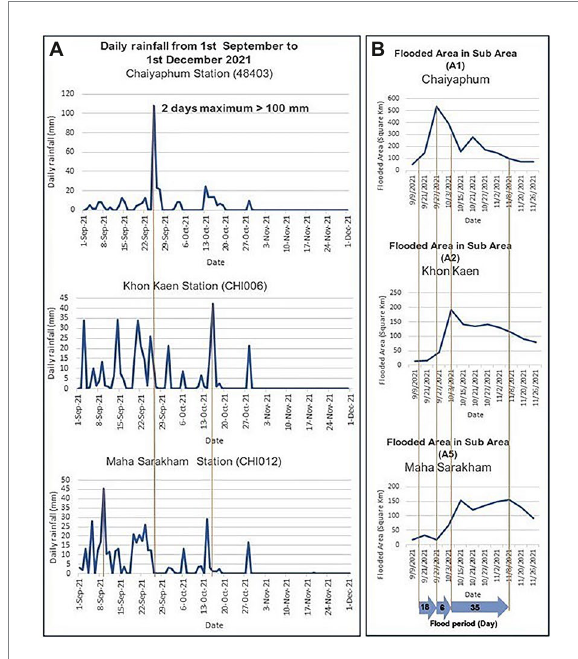
FIGURE 2 (A) Records of daily rainfall on September 1 to December 1, 2021, from the Chaiyaphum, Khon Kaen, and Maha Sarakham weather stations. Only one dominant peak was recorded at 108 mm (top graph) during September 23–25, 2021 at Chaiyaphum, the upstream part of the catchment. The other two stations, situated downstream from Chaiyaphum, showed several peaks in the range of 25–40 mm/day (Khon Kaen station, middle graph) and an average of 25 mm/day at the Maha Sarakham station (bottom graph). (B) Flood area and periodical records from the three weather stations. Two days of heavy rain with a maximum daily rainfall of 108 mm made a vast flooded area for a few weeks at Chaiyaphum before the water moved to Khon Kaen and reached Maha Sarakham over the next 35